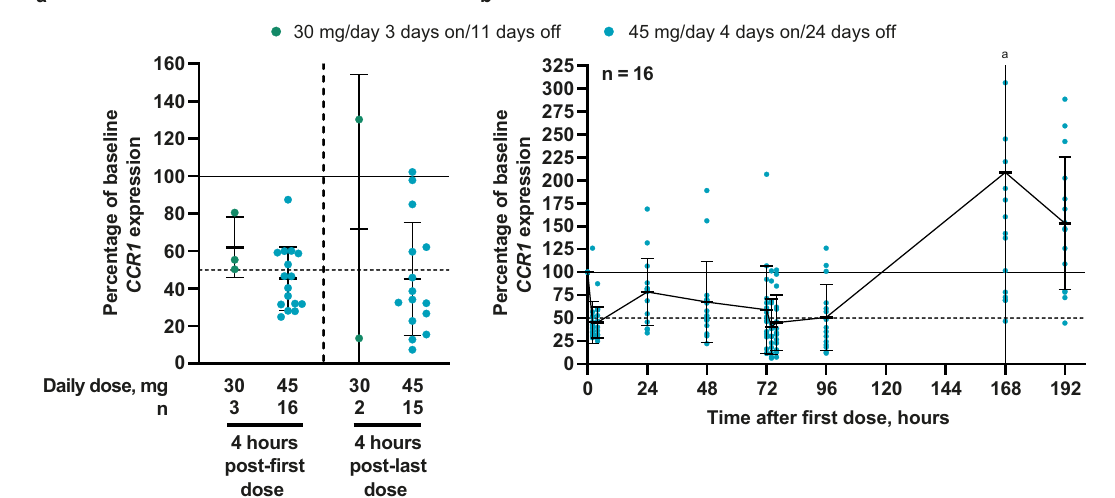
Fig.6|Blood CCR1 mRNAlevelsinpartB.a Fourhoursafterthe fi rst(left)andlast dose (right) in part B, and b from 0 – 192h in patients receiving trotabresib 45mg/ day 4 days on/24 days off. Forboth fi gures, colored data points indicate individual patient values for the percentage of baseline CCR1 expression and black lines and